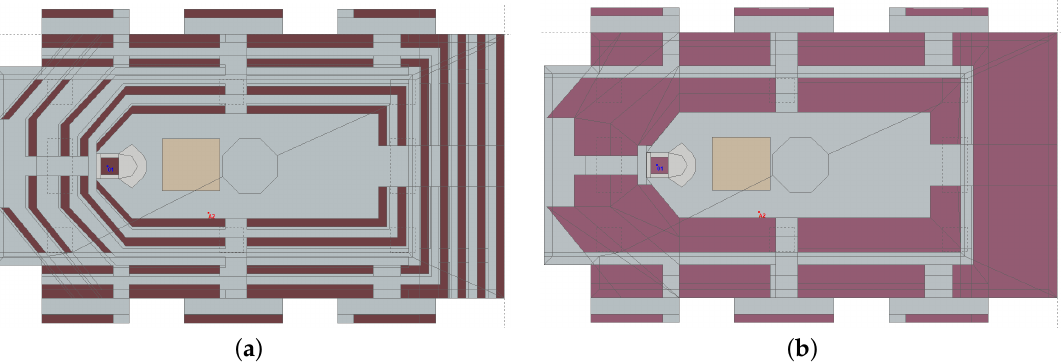
Figure 6. The updated version of the model extended on the north and south walls by the window areas in CATT-Acoustic. ( a ) A detailed simulation of the benches is represented. ( b ) The benches’ surfaces have been simplified.